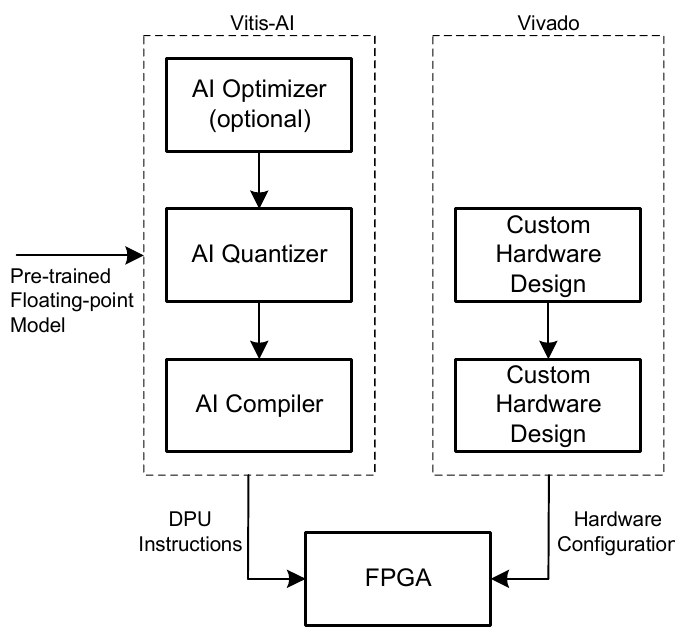
Figure 1. Project flow using